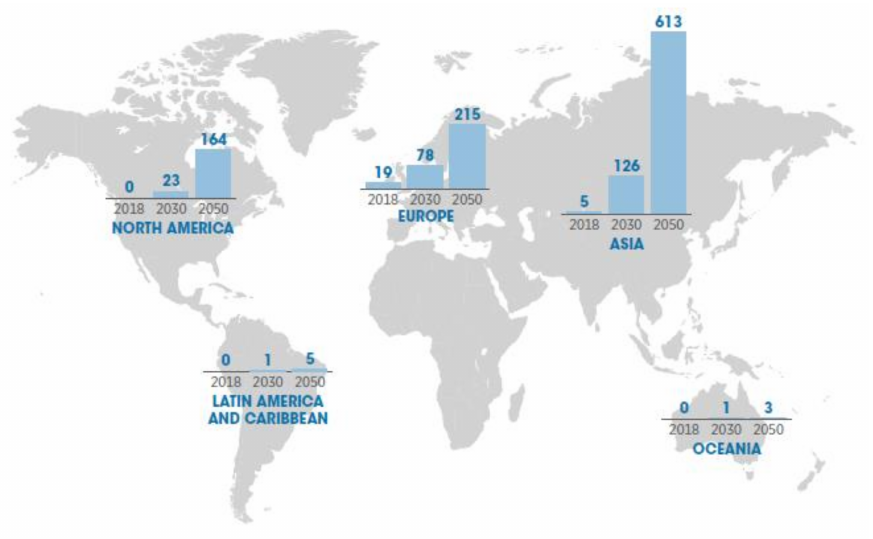
Figure 1. Installed capacities (GW) of offshore wind; Reprint with permission [5]; 2019,